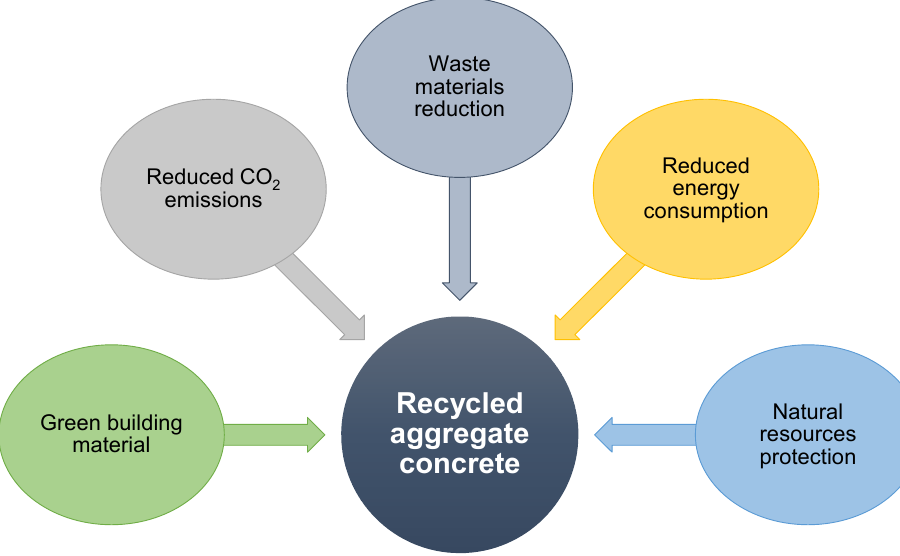
Figure 15. Benefits related to the adoption and application of recycled aggregate concrete.